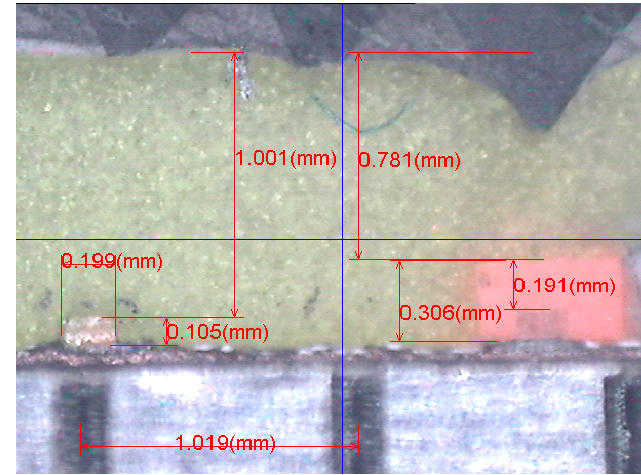
Figure 6. A microscopic image of stacked type packaged filament.